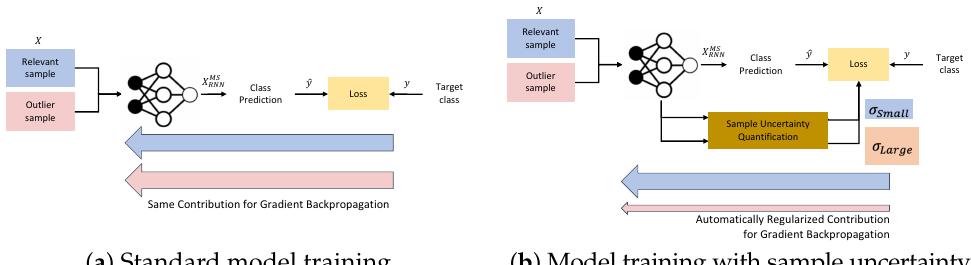
Figure 7. Comparison between model training with (right) and without considering sample uncer- tainty (left). Information flows related to outlier and relevant samples are colored in red and blue, respectively. The size of the backward arrows illustrates the relative contribution of the samples to the overall gradient signal as it is distributed to the model parameters through